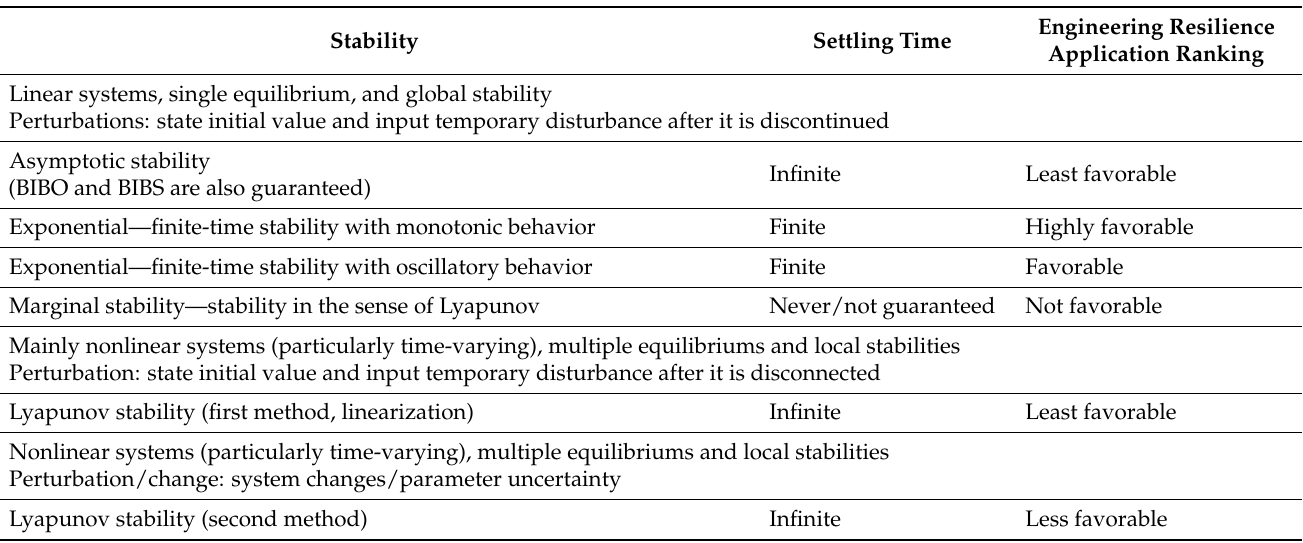
Table 4. Dynamic stability application to engineering resilience with a focus on the system